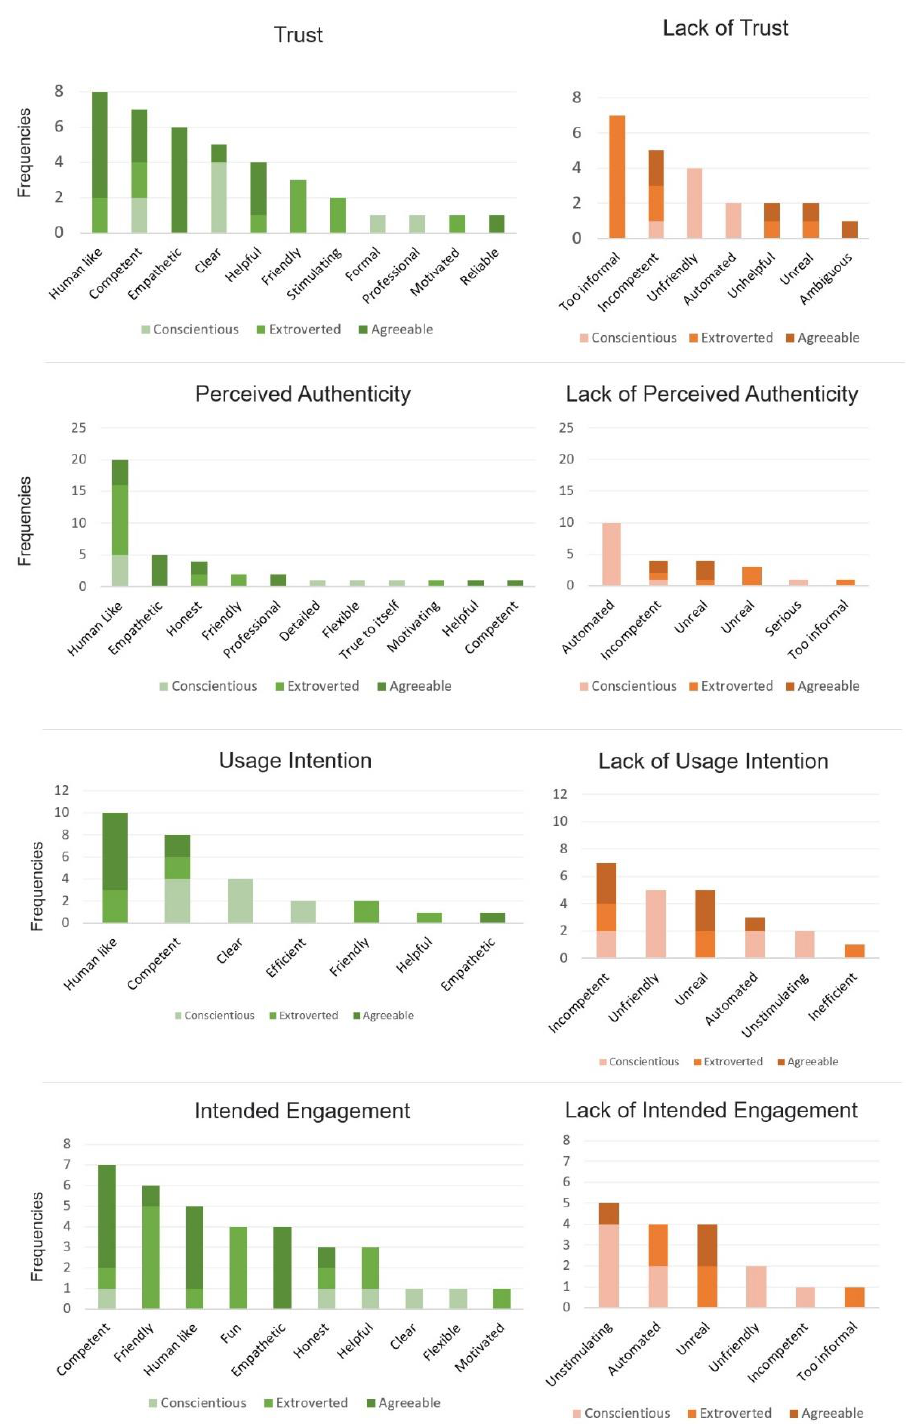
Figure A1. A visualization of the themes of students ’ explanation of their ratings of certain chatbot.